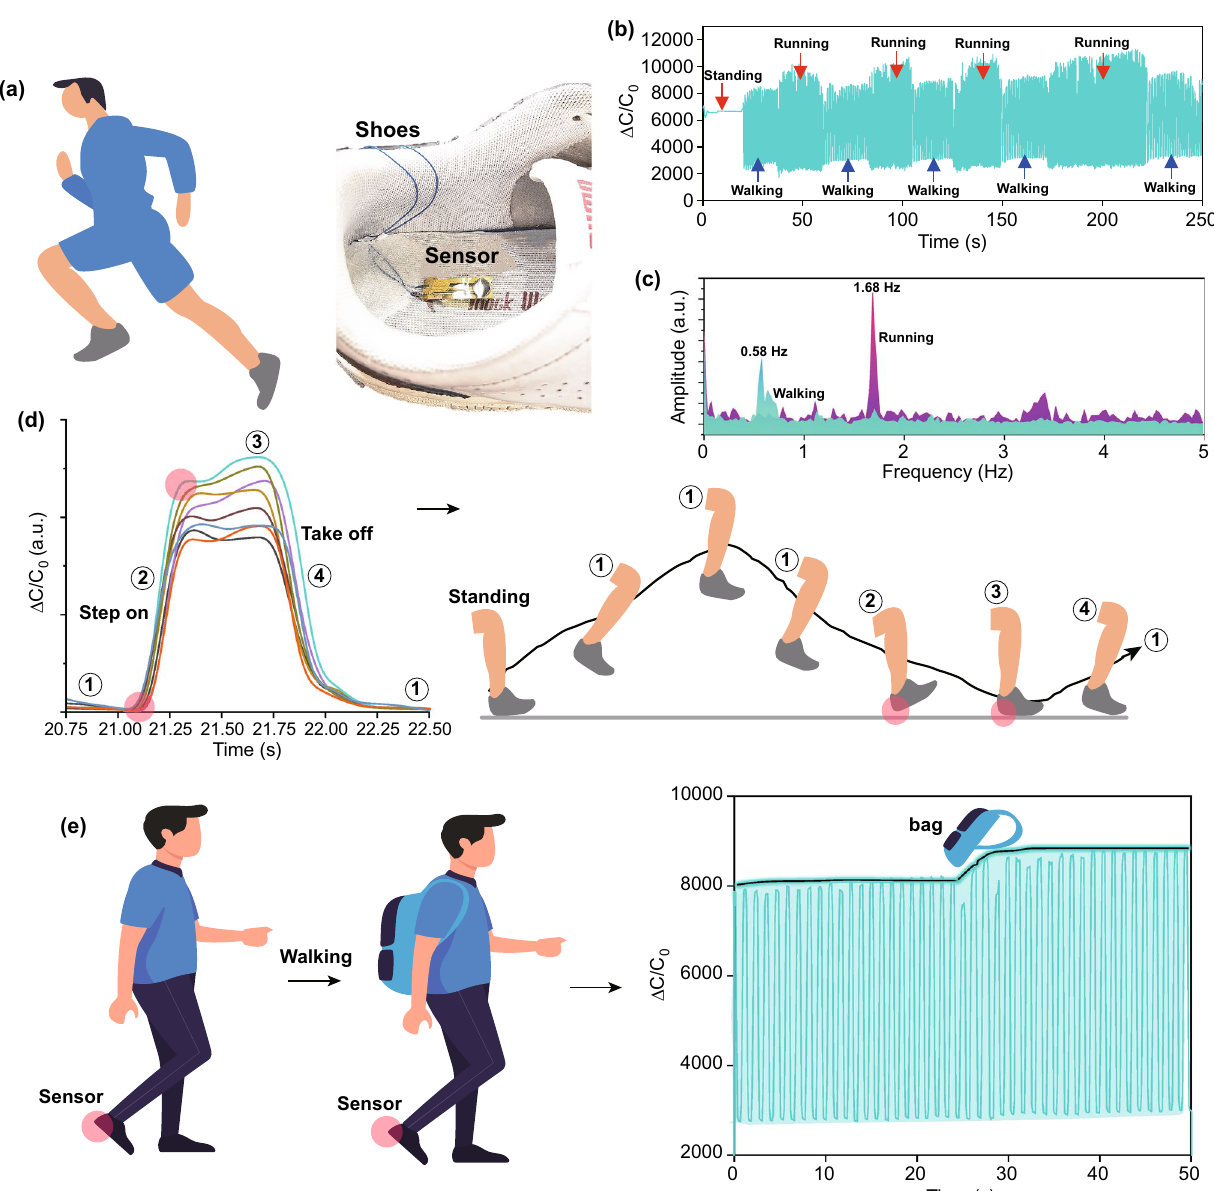
Fig. 5 Practical application of the flexible iontronic sensor on monitoring of physical activity. a Optical image of the sensor mounted into the shoes to monitor the physical activity. b Physical activity such as standing, walking and running were monitored by the sensor. c The FFT spec- trum of the walking and running obtained from ( b ). d Walking state was analyzed by the flexible sensor. e Sensor’s sensitivity on monitoring the walking statues with different bearing